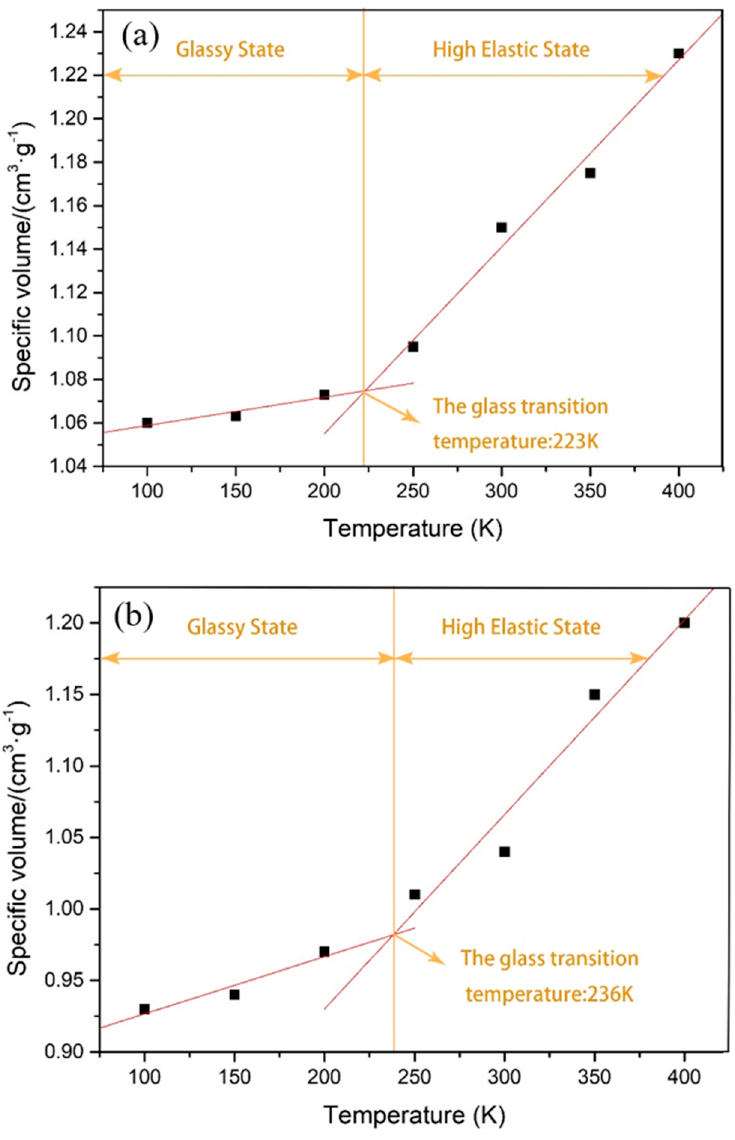
Figure 5. ( a ) Transition temperature curve for NR glass; ( b ) transition temperature curve for GNS/NR glass.